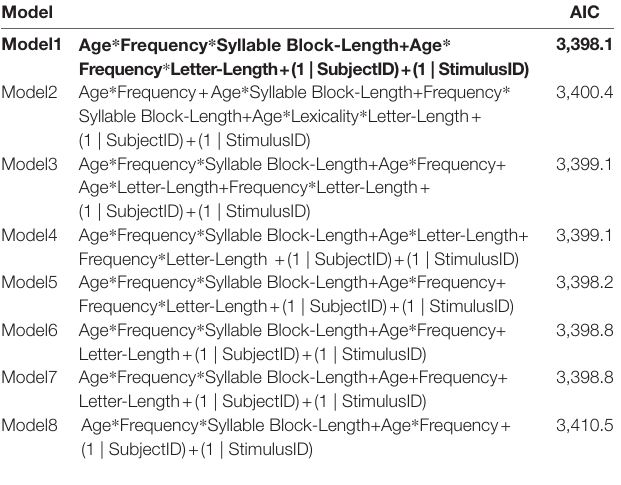
TABLE 4 | Comparison of mixed-effects regression models on reading accuracy: age × frequency × length on words (best-fitting model in bold).